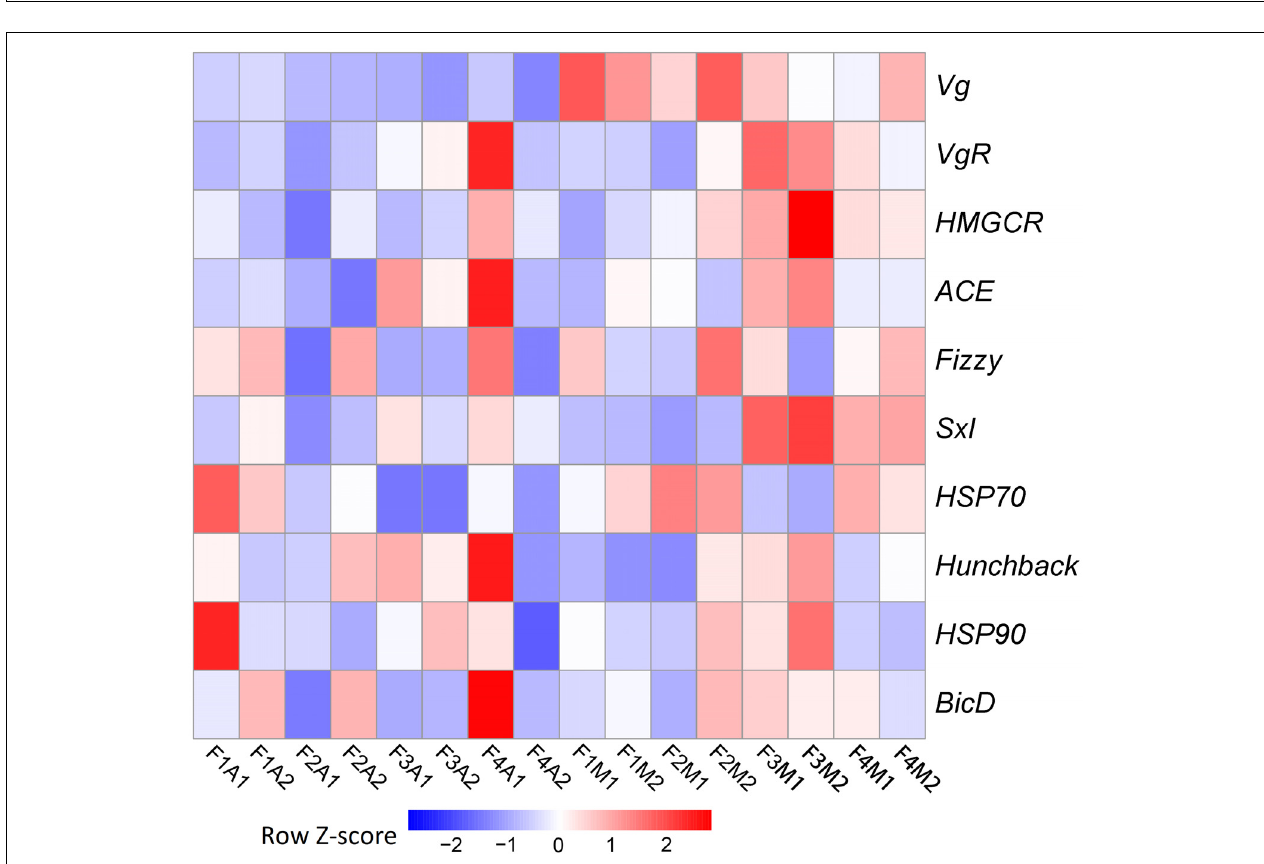
FIGURE 4 | Heatmaps based on the normalized expression of 10 selected fecundity-related genes in each line.